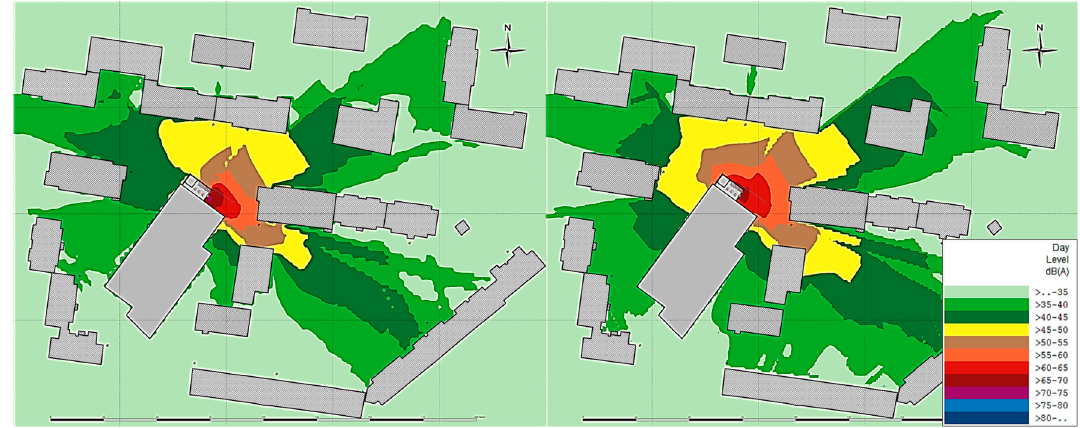
Figure 6. Scenario 2 with acoustic barrier of 2.3 m—Lday with all noise sources ( left : 4 m, right : 10 m).